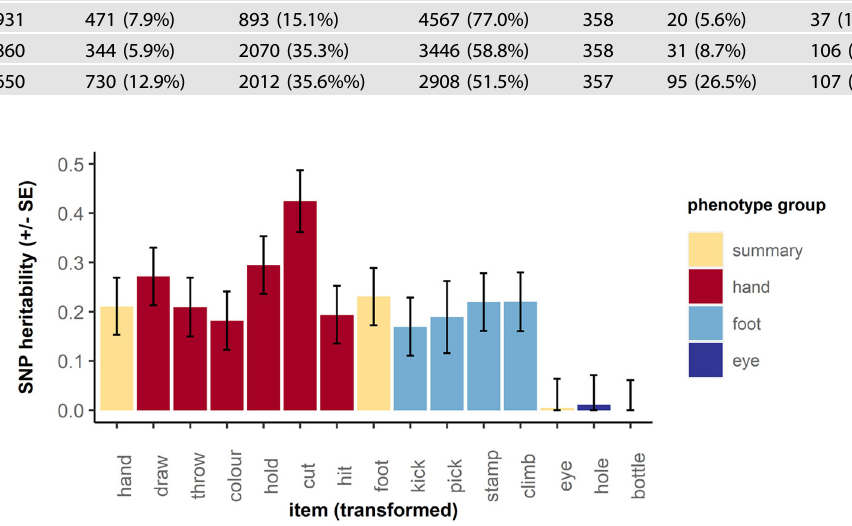
Fig. 2 SNP-h 2 estimates for laterality measures after transformation into quantitative scores in ALSPAC. Results are shown for individual items and summary measures (yellow). Bars represent standard errors.